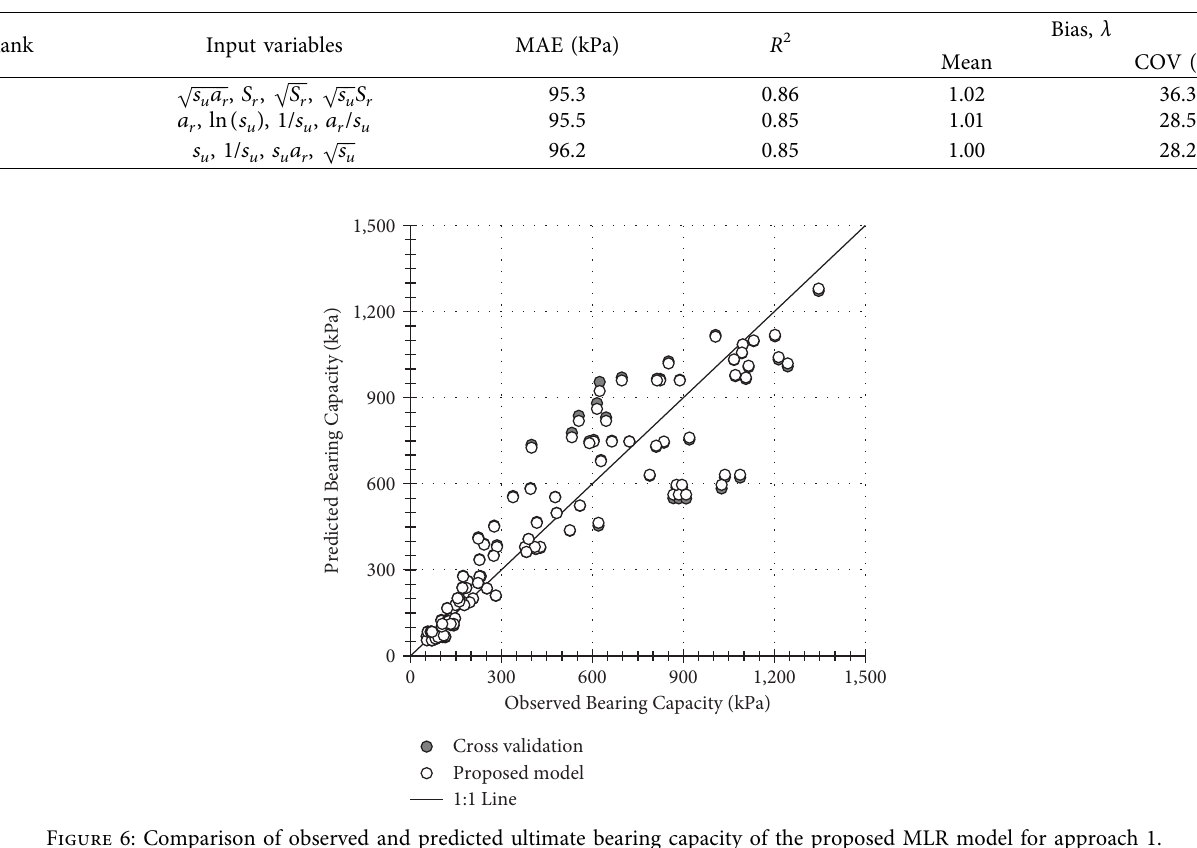
Table 3: Cross-validation error evaluation for input variables (Approach 1).